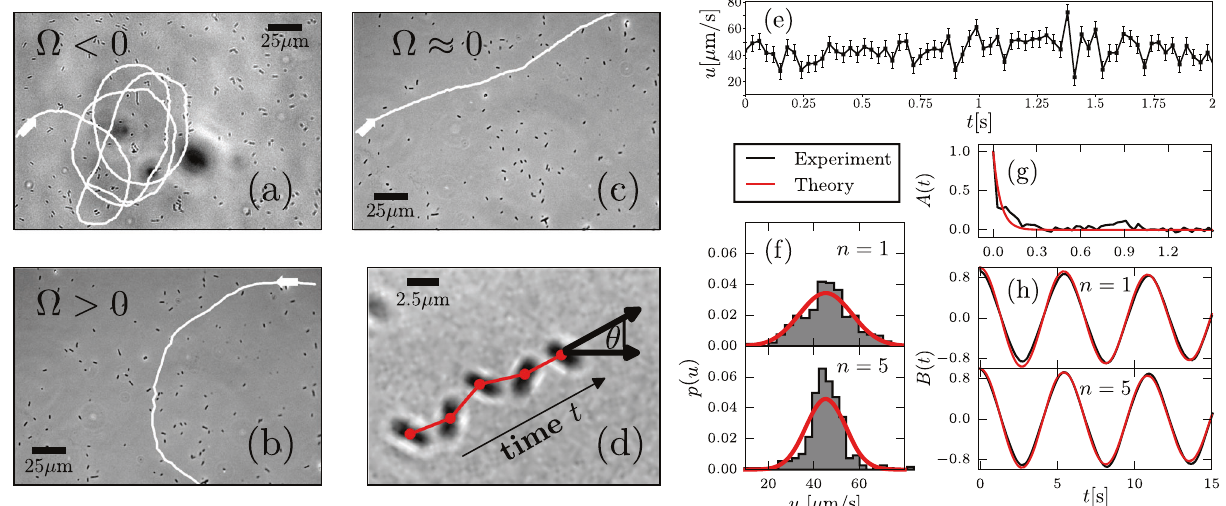
Fig. 1 Experimental trajectories in the absence of host cells (HCs) and estimation of motility parameters. In a – c , we chose in each of them one motile bacterium, with a distinct angular speed Ω , from a population that includes motile as well as non-motile bacteria, and display its trajectory. The different panels illustrate the presence of different types of bacterial trajectories. d At short time-scales we observe that the longest axis of the bacterium oscillates, however, the center of mass of the bacterium moves along smooth paths. e Speed fl uctuations: speed u — computed using two consecutive frame, i.e., n = 1 — vs time in a representative trajectory. Error bars correspond to the experimental SE in the estimation of u , see details on the Supplementary Note 2. f Distribution of the speed u computed for n = 1 and 5 values. The red curve corresponds to Eq. (4). g Speed correlations A , using n = 1. The red curve corresponds to Eq. (1). h Moving direction correlations B , averaging over 1 Δ t and 5 Δ t . The red curve corresponds to Eq. (2). Note that correlations remain unchanged for n = 1 and n = 5. For further details, see Supplementary Note 1 and 2, as well as Supplementary Fig.